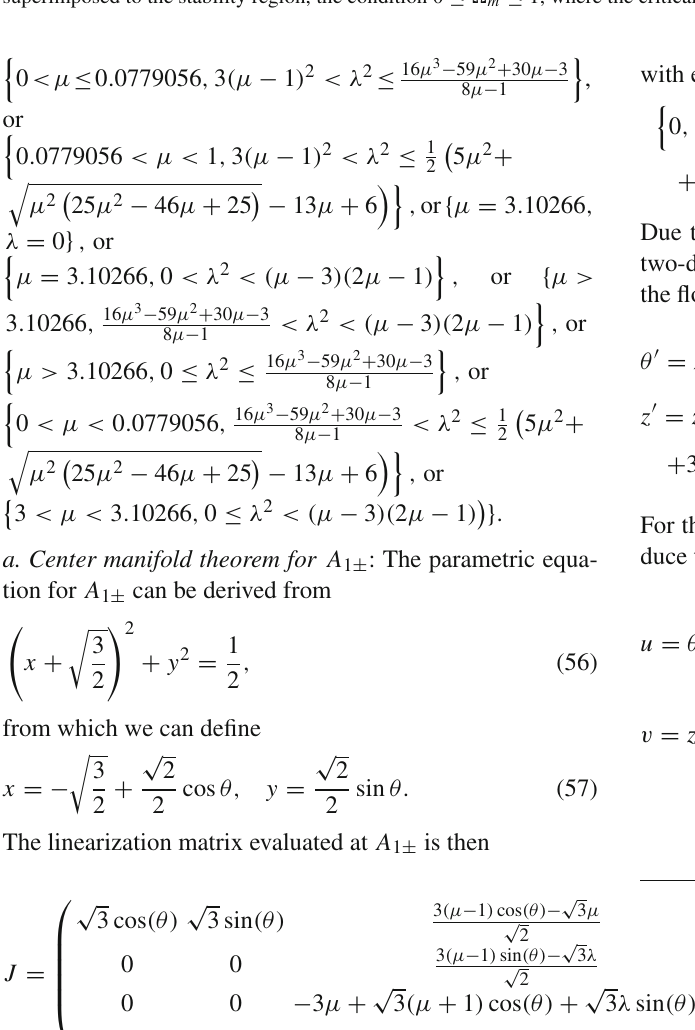
Fig. 9 Region plots in the space of variables { λ,μ } where the two points A 2 (left plot) and A 3 (middle plot) are stable. In the right plot it is superimposed to the stability region, the condition 0 ≤ (cid:11) m ≤ 1, where the critical point A 3 is physically